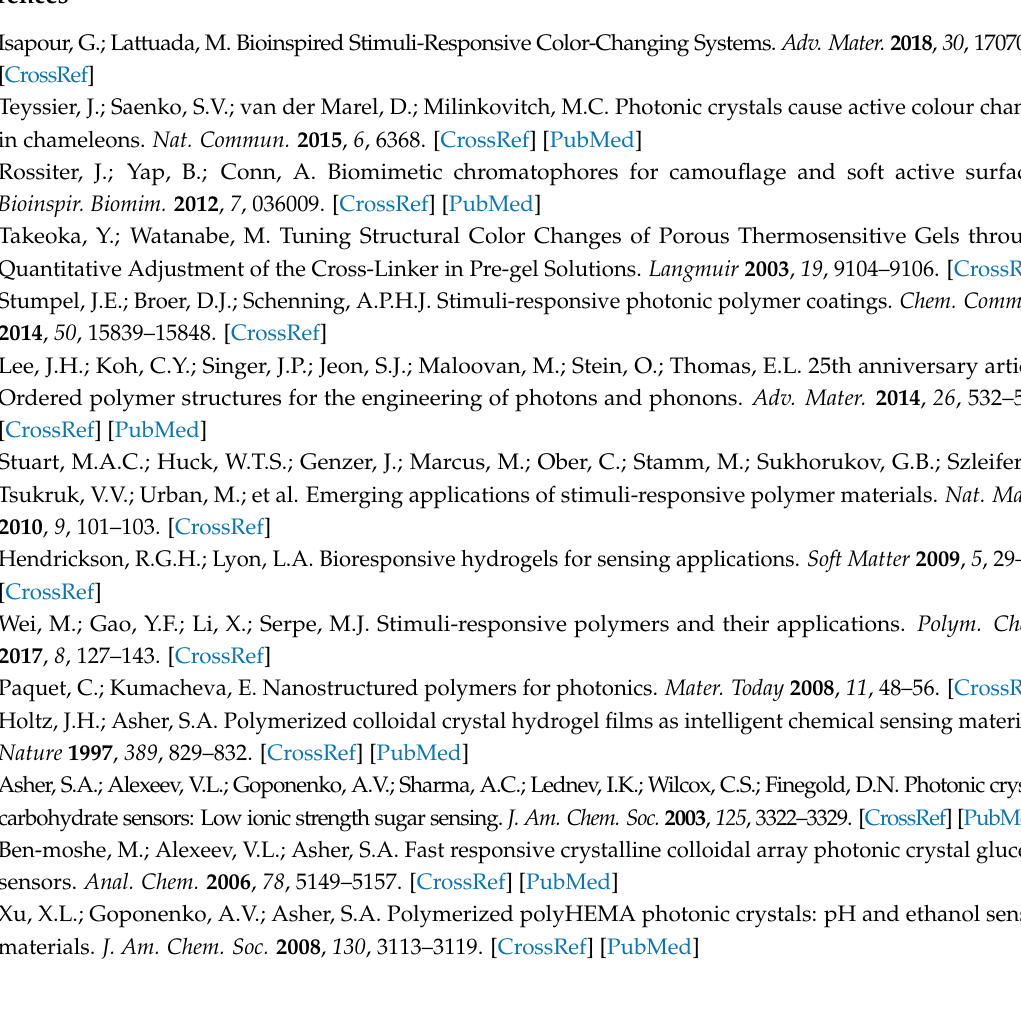
Figure S1: SEM images of UPPGF-0 after equilibration in pH 5.08, pH 4.20, pH 3.39, and pH 2.57 buffer solution; Figure S2: SEM images of UPPGF-2 after equilibration in pH 5.08, pH 4.20, pH 3.39, and pH 2.57 buffer solution; Figure S3: SEM images of UPPGF-6 after equilibration in pH 5.08, pH 4.20, pH 3.39, and pH 2.57 buffer solution; Figure S4: SEM images of UPPGF-8 after equilibration in pH 5.08, pH 4.20, pH 3.39, and pH 2.57 buffer solution; Figure S5: Corresponding shifts of the reflectance peak of UPPGF-x (x = 0 min, 2 min, 4 min, 6 min, 8 min) after equilibration in pH buffer